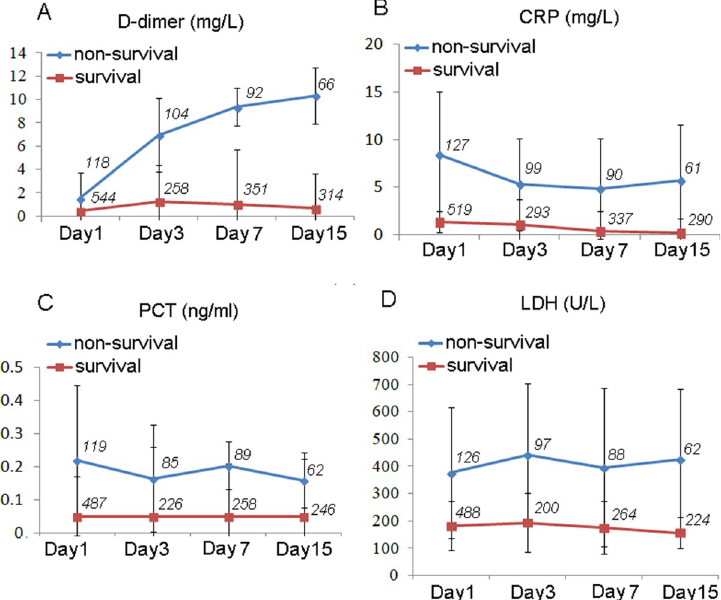
Fig 1. Dynamical changes of the risk factors in the patients with COVID-19 during hospitalization. Figure shows dynamical changes of CRP (A), LDH (B), PCT(C) and D-dimer (D) in patients within 15days from admission onset. We stratified the patients into two subgroups: non-survivals and survivals. The case numbers in the dynamic analysis are shown as italics in the pictures. Data represent mean ± SD. Abbreviations: D-dimer, Dimerized plasmin fragment D; CRP, C-reactive protein; LDH, lactate dehydrogenase; PCT,